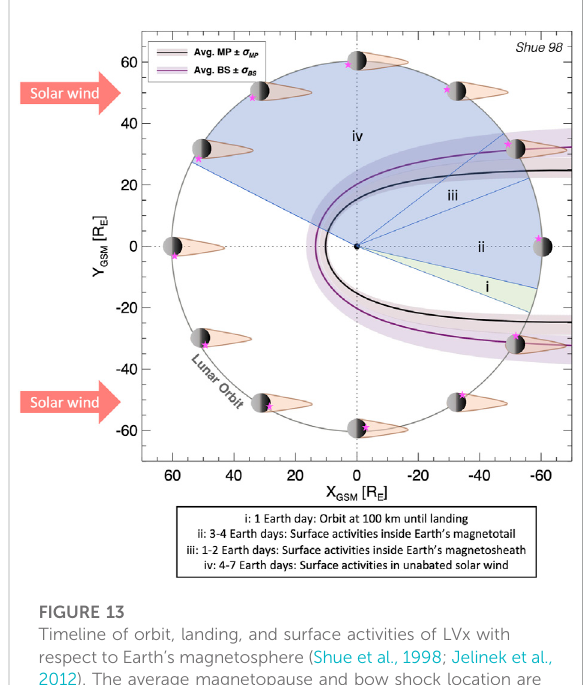
FIGURE 13 Timeline of orbit, landing, and surface activities of LVx with respect to Earth ’ s magnetosphere (Shue et al., 1998; Jelinek et al., 2012). The average magnetopause and bow shock location are based on 10 years (2010 – 2020) of solar wind and IMF observations from the OMNI dataset (Papitashvili and King 2020). Moon and lunar wake scaled 200 × to visualize illumination conditions at RG/LVx landing site (pink star). Earth ’ s average magnetopause location is indicated by a black line with salmon shaded variance and the average bow shock location is indicated by a purple line with lilac shaded variance. The lunar wake is indicated by an orange tail behind the Moon. Timeline based on solar wind conditions observed by the Apollo Solar Wind Spectrometer experiment (Snyder et al., 1970; Clay et al.,